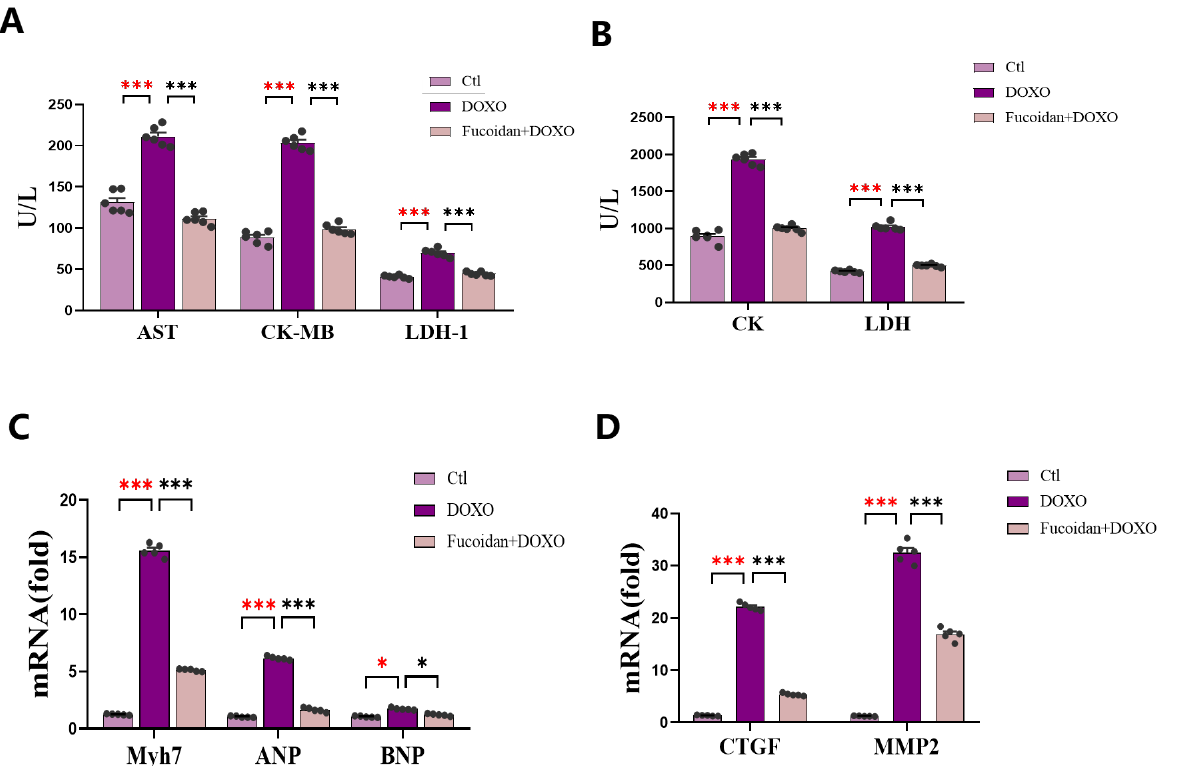
Figure 3. Fucoidan plays a key role in DOXO-induced cardiac structure and function damage prevention. ( A ) Levels of AST, CK-MB and LDH-1 in the mice serum. ( B ) Levels of CK and LDH in the mice serum. ( C ) Levels of cardiac dysfunction-related genes’ mRNA expression: ANP , BNP and Myh7 . ( D ) Levels of cardiac remodeling-related genes mRNA expression: CTGF and MMP2 . Repeating n = 6 in each group. Both C and D show that DOXO group had higher expression than ctl group, and fucoidan gavage was capable of impairing the cardiac function. * p < 0.05, *** p < 0.001. The red asterisk is used to indicate the difference between the DOXO group and the Ctl group, and the black asterisk is used to indicate the difference between the DOXO group and the Fucoidan + DOXO group.